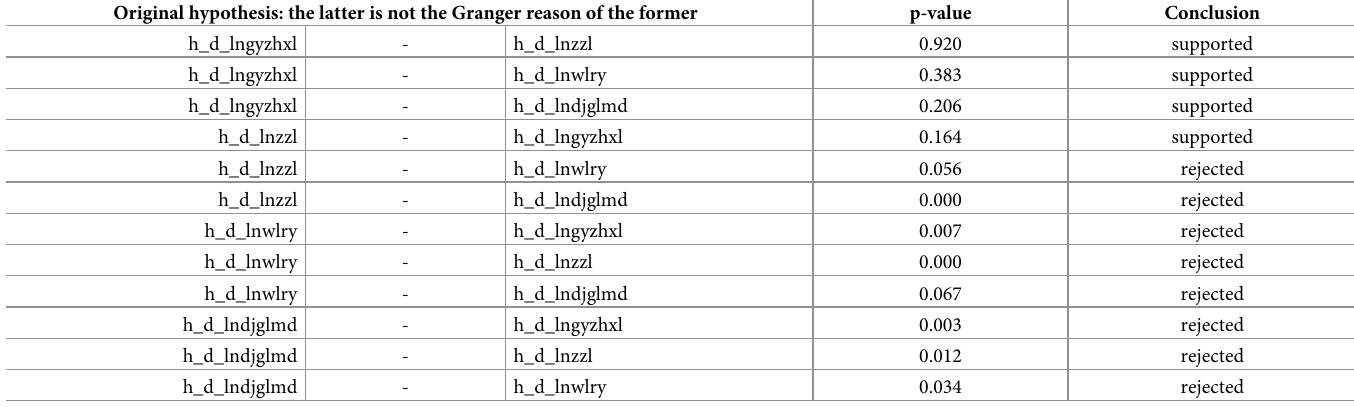
Table 9. Granger causality test of logistics industry and the comprehensive technical efficiency of manufacturing industry. Original hypothesis: the latter is not the Granger reason of the former p-value Conclusion